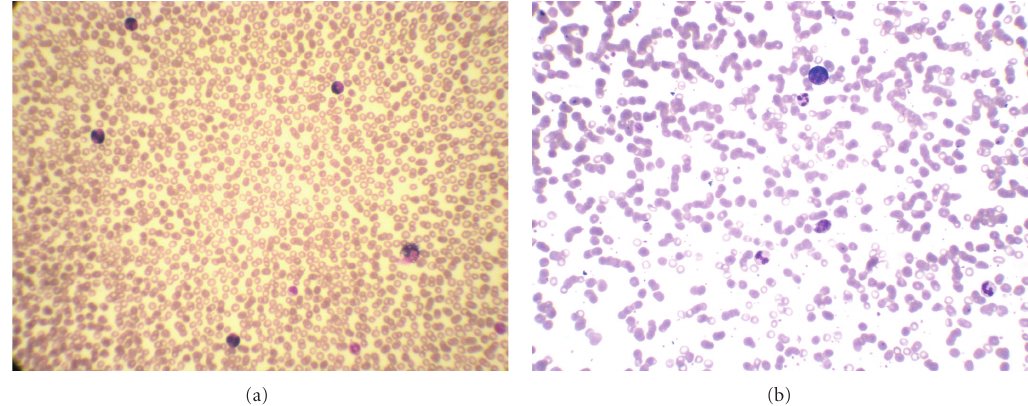
Figure 3: Blood smear (Wright Giemsa). (a) The examination before surgery showed 52% eosinophils. (b) The examination after surgery showed 10%